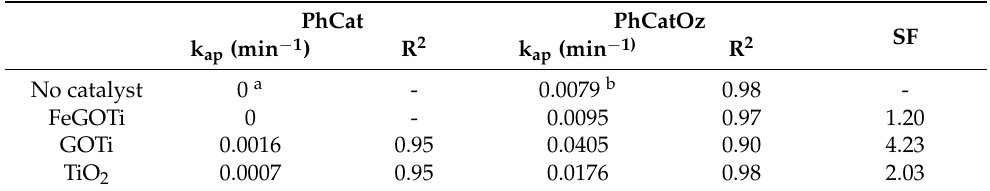
Table 2. Values of k ap and synergy factor of TOC removal for the catalysts in PhCat, CatOz and PhCatOz